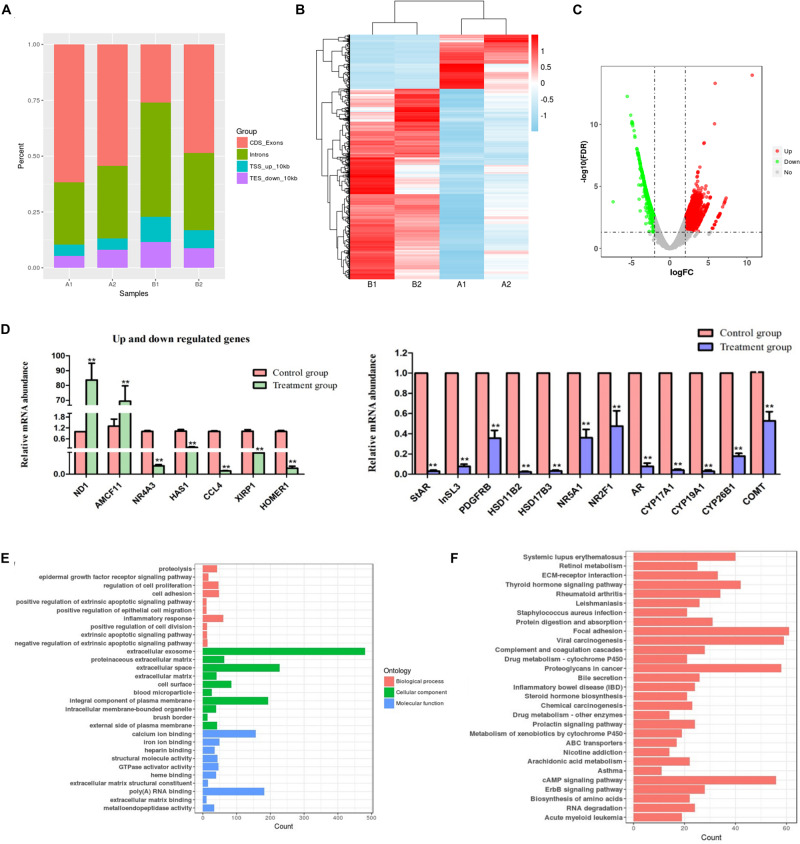
mRNA-seq data and differentially expressed genes analysis. (A) Percentage of reads mapped to different genome regions. CDS, coding sequence; TES, transcription end site; TSS, transcription start site. A1 and A2 represent primary group; B1 and B2 indicate EDS-treated group. (B) Clustering analysis of DEG. Up- and down- regulation are separately colored in red and blue. (C) Volcano plots showing the differently expressed genes in primary group compared to EDS-treated group. (D) The mRNA expression levels of up and down regulated genes and “steroid hormone biosynthesis” pathway related genes. The error bars are the S.E. of duplication. ** represent P < 0.01. (E) Significantly different top 10 GO terms correspond to different categories in primary group compared to EDS-treated group. (F) Significantly different top 30 KEGG terms correspond to different categories in primary group compared to EDS-treated group.